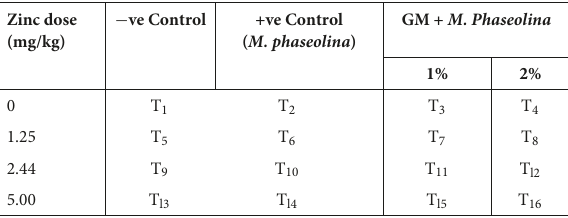
TABLE 1 Treatments designed for the current